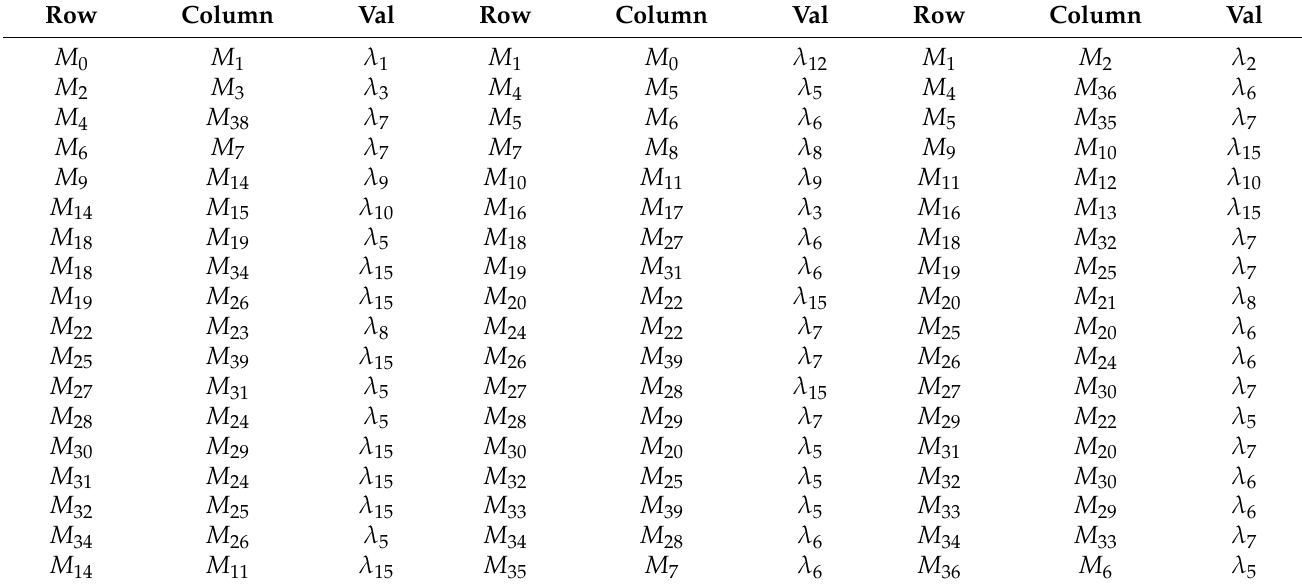
Table 4. Transition probability matrix of the GSPN